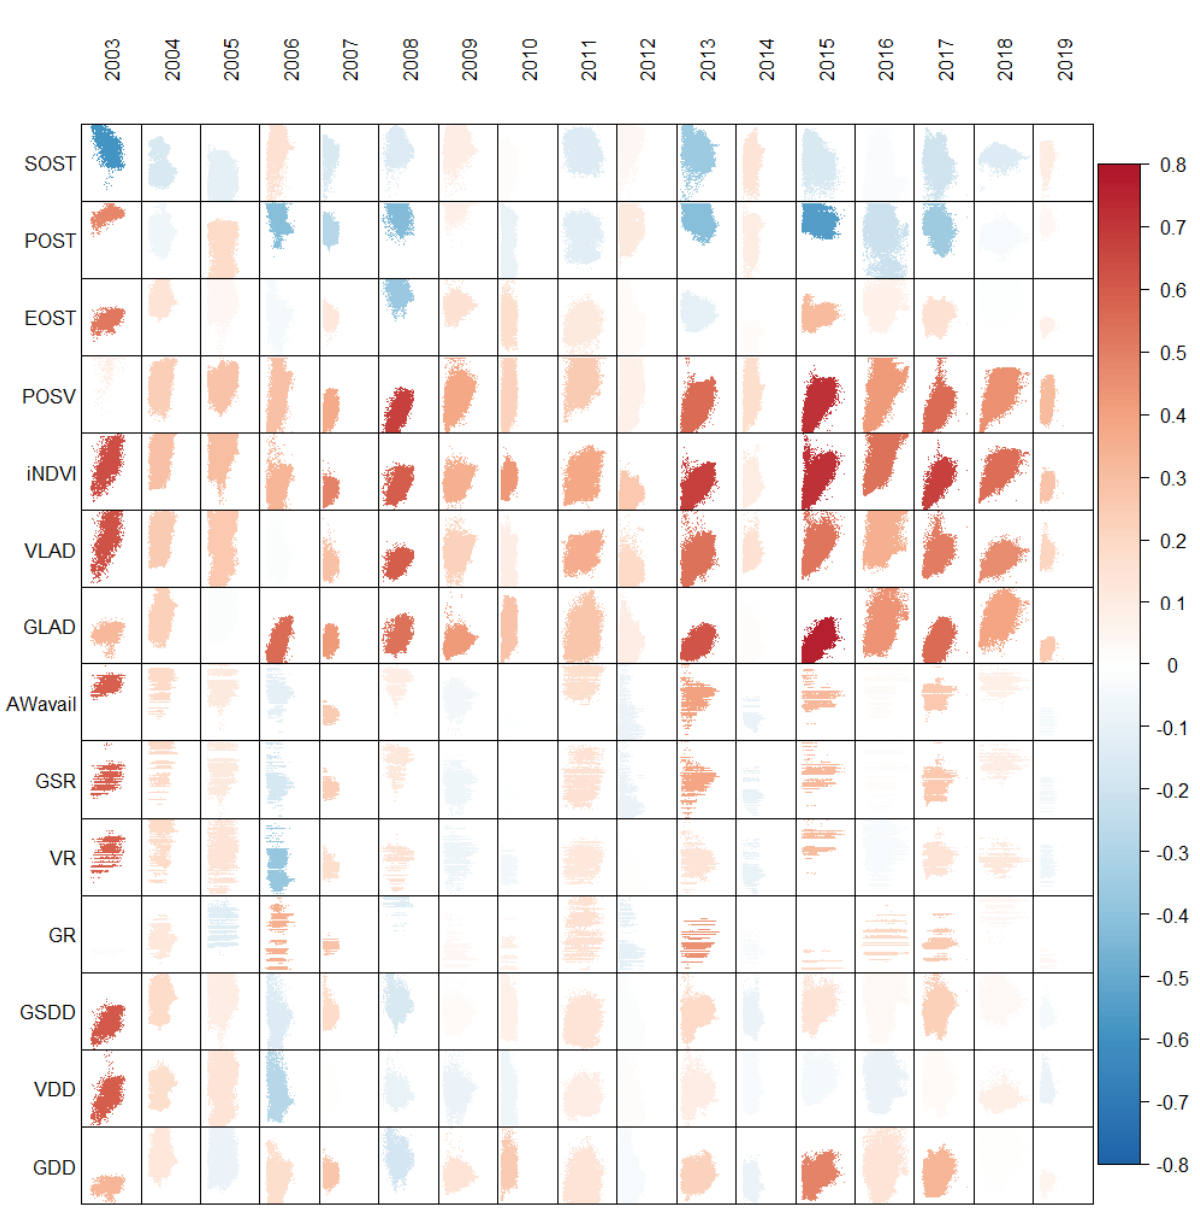
Figure 4. Scatterplots of yield (x-axes) and phenological and seasonal climate metrics (y-axes) for each year from 2003 to 2019. Data are coloured according to their correlation.